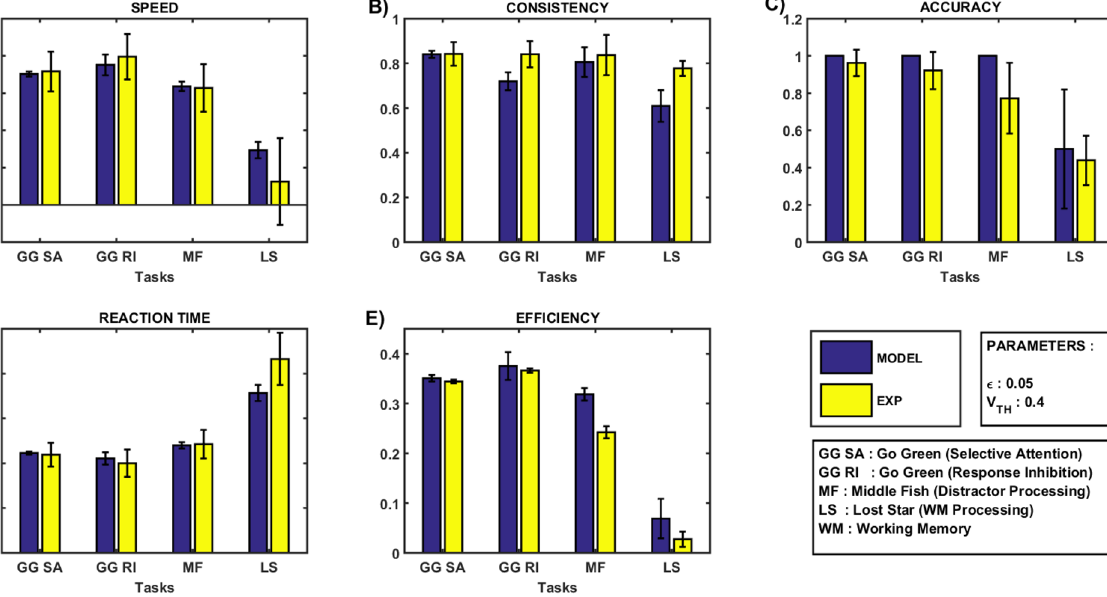
Figure 5. Comparison of performance of the GRLDNN model with the experimental results and data adapted from 8 ( A ) Speed ( B ) Consistency, ( C ) Accuracy, ( D ) Reaction Time, ( E ) Efficiency. EXP, experimental results; MODEL, Model performance